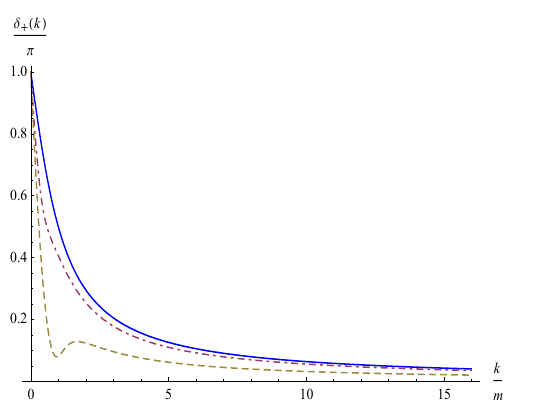
Figure 3 . Plot of the bosonic phase phifts (cid:14) + ( k ) =(cid:25) as a function of k=m . The solid, dotdashed and dashed lines correspond to B = 0, B = 0 : 5, and B = 1,